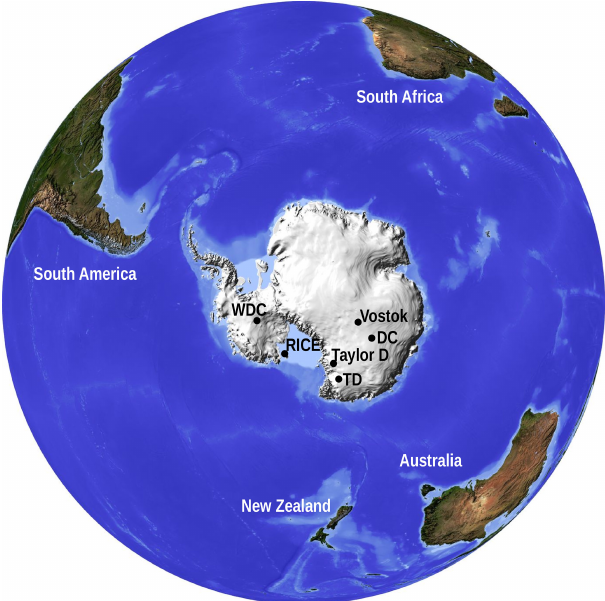
Figure 1. Map of the Antarctic region including the Talos Dome (TD), Vostok, Taylor Dome (Taylor D), Dome C (DC), RICE and WAIS Divide ice core sites mentioned in this